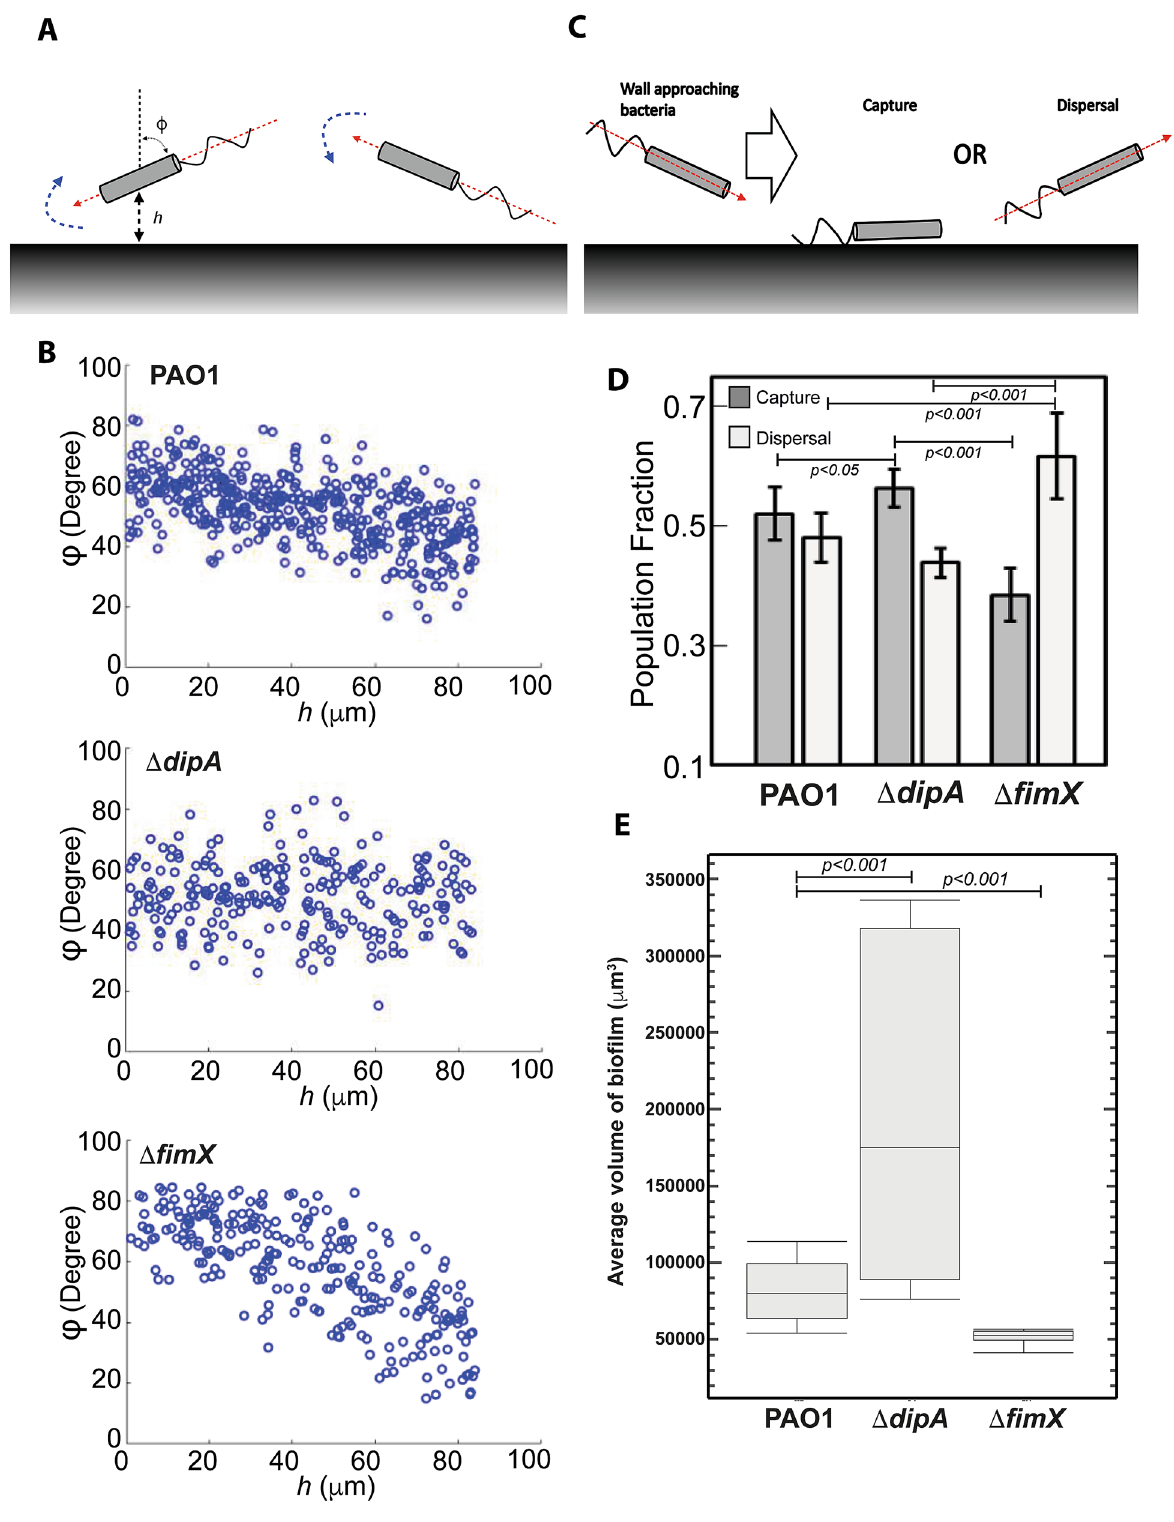
Figure 4. ΔdipA does not reorient to be parallel to the wall surface, which correlates to a higher capture frequency for better biofilm formation. ( A ) Swimming bacteria reorient to be parallel to the surface of the wall. When a cell moves towards a wall at an orientation φ (dashed red arrow), there will be a gradient in the flow field that will cause the cell to rotate until φ = 0 (dashed blue arrow). ( B ) The cell trajectory angle of approach towards the wall, φ, is obtained for each individual cell trajectory. The number of PAO1 and ΔfimX with φ ending to 0 increases as the distance to the wall h decreases. ( C ) Schematic of bacterial cell approaching a wall, capture and dispersal. ( D ) ΔdipA showed a significant higher percentage of capture events than PAO1 ( p < 0.05) and ΔfimX ( p < 0.001), whereas ΔfimX sho wed a significant higher percentage of dispersal when compared with PAO1 ( p < 0.001) and ΔdipA ( p < 0.001). ( E ) The average volume of biofilm of PAO1, ΔdipA and ΔfimX